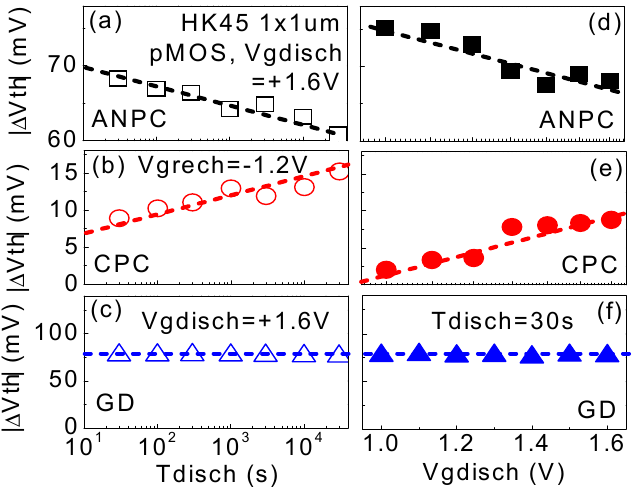
Figure 27. The ANPC and CPC measured by the SDR technique using different discharging times ( a , b ) and discharging voltages ( d , e ). The total generated defect ( c , f ) (i.e., the sum of ANPC and CPC) was independent of the measurement conditions [38].